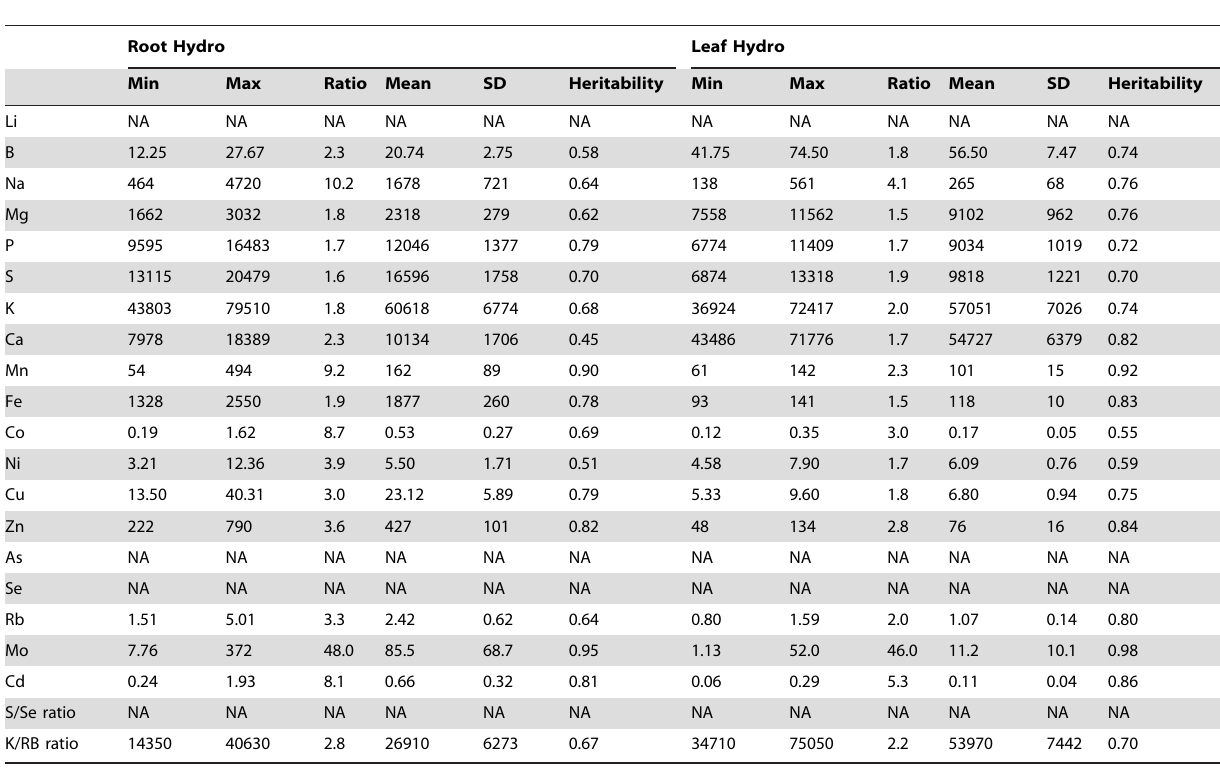
Table 1. Summary of Root Hydroponic and Leaf Hydroponic